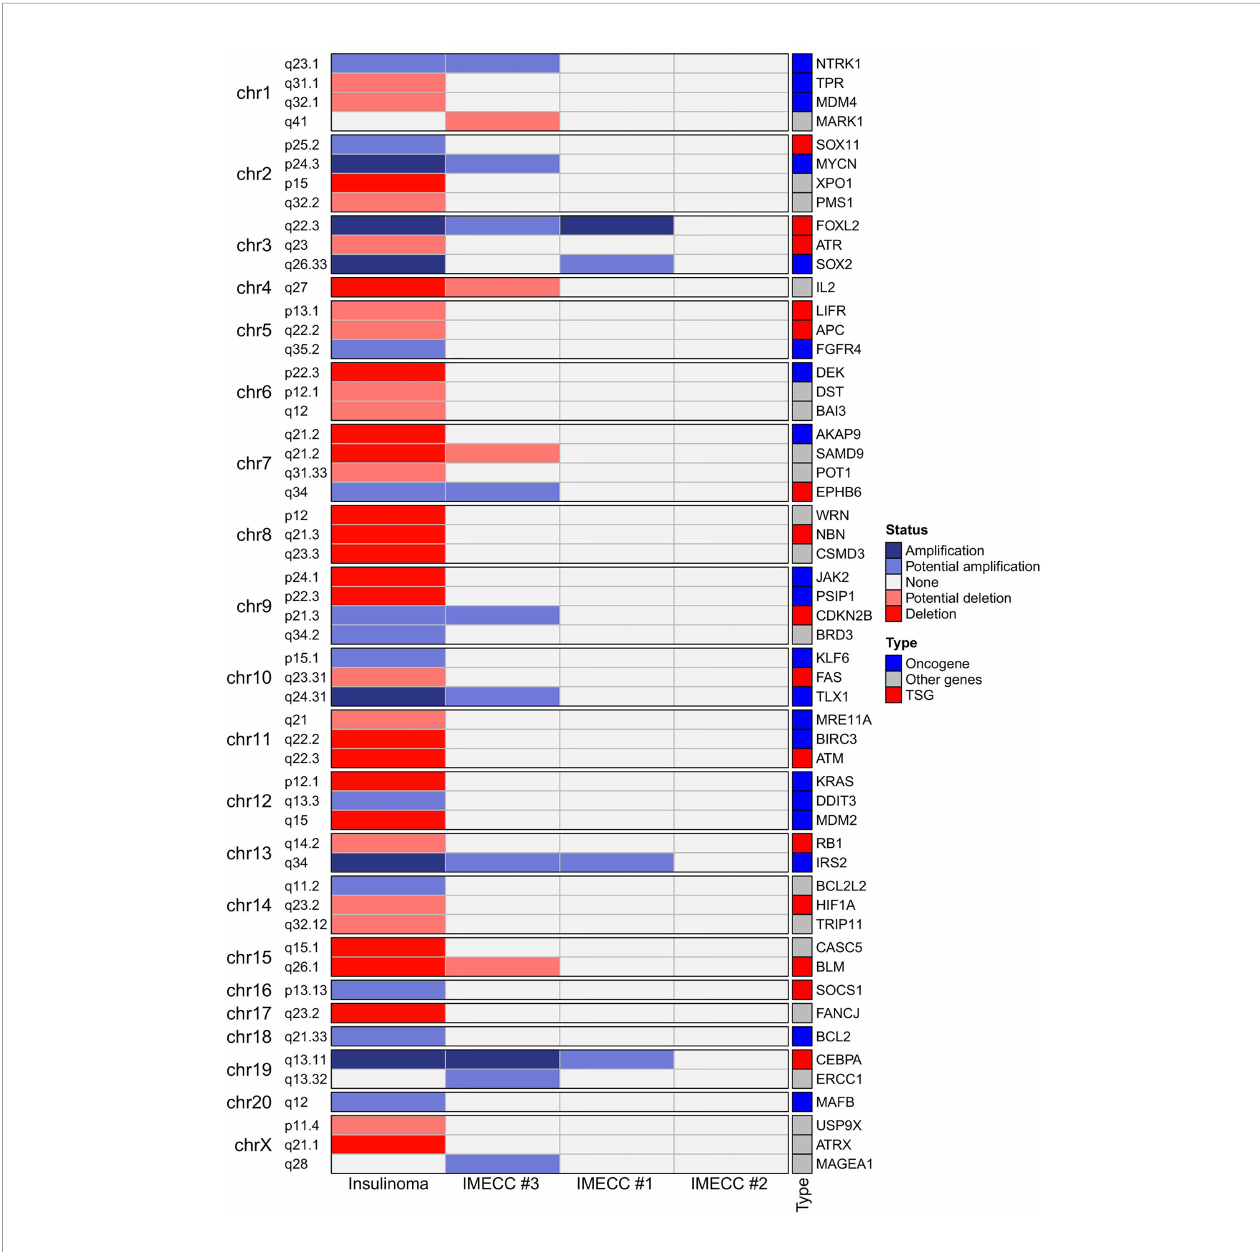
FIGURE 2 | Heatmap of the results of